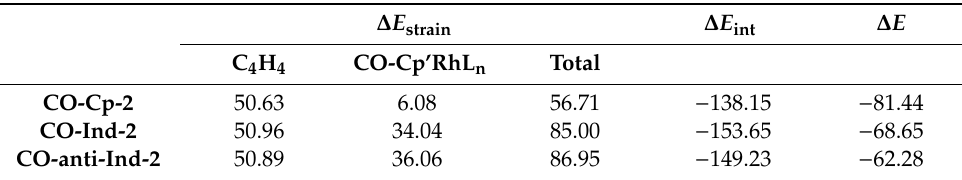
Table 5. Activation strain analysis (ASA) of CO-Cp-2, CO-Ind-2 , and CO-anti-Ind-2 ; all values are in kcal mol − 1 . The fragments are: CO-Cp’Rh (Cp’ = Cp, Ind, and anti-[Cr(CO) 3 Ind]) and the C 4 H 4 moiety (the reference are two acetylene molecules).